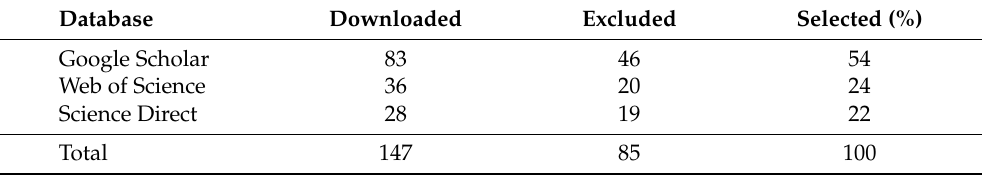
Table 2. Distribution of compiled literature from the three database sources from 2010 to